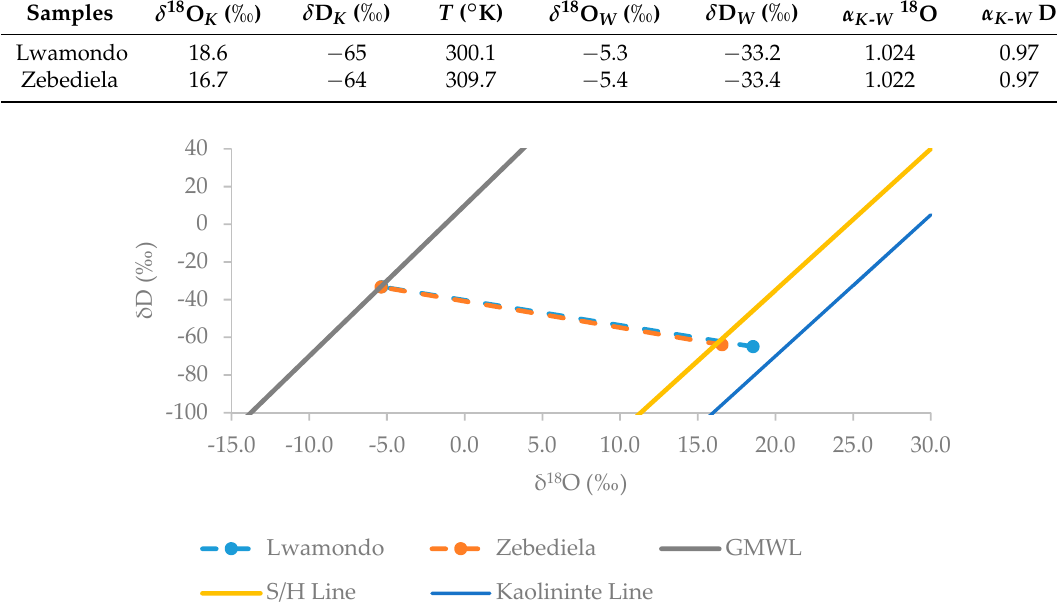
Table 9. Mean isotopic composition of meteoric water and kaolinite–water fractionation factors.